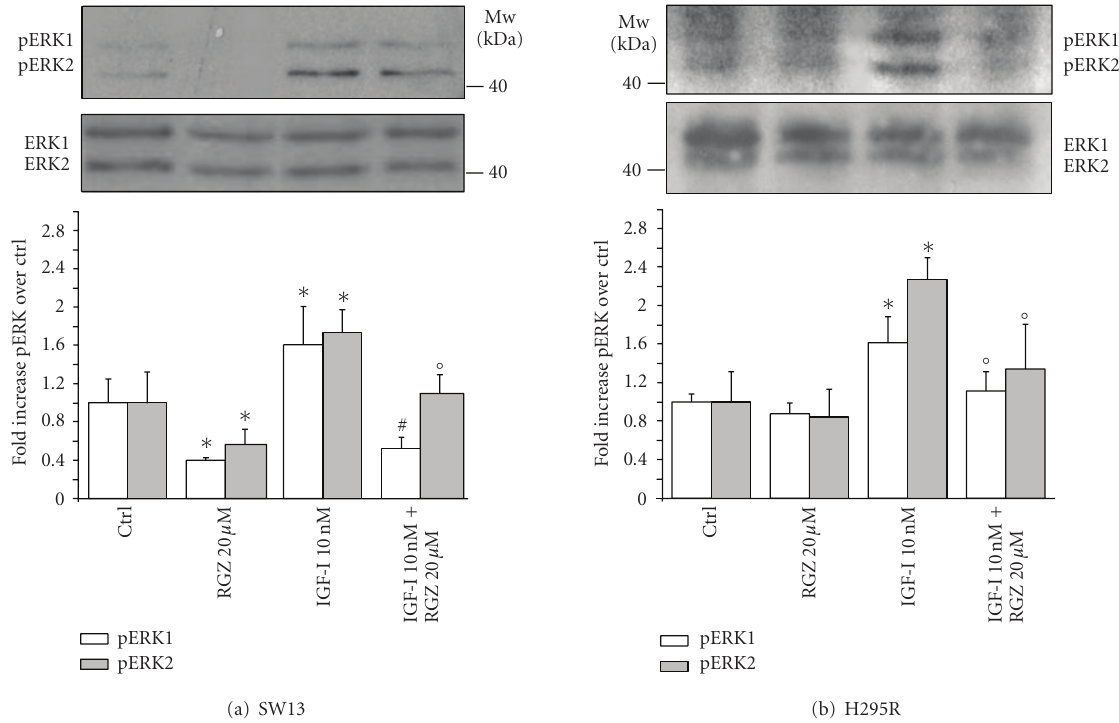
Figure 6: RGZ dampens IGF-I stimulated ERK1/2 phosphorylation . Western blot analysis of SW13 (a) and H295R (b) cell lysates following 15- minutes stimulation with 10nM IGF-I and 20 μ M RGZ, reveals an increased phosphorylation of ERK1/2 following IGF-I, which is reverted by RGZ. Lane protein normalization for ERK1/2 is shown in the middle panels. Molecular weight markers are indicated. Mean ± SE of phospho-ERK1/2 band intensity over respective Ctrl is shown in 3 independent experiments for SW13 (a) and H295R (b) cells (lower panels). ∗ P < 0 . 05 versus respective Ctrl; ◦ P < . 05 and # P < . 005 versus